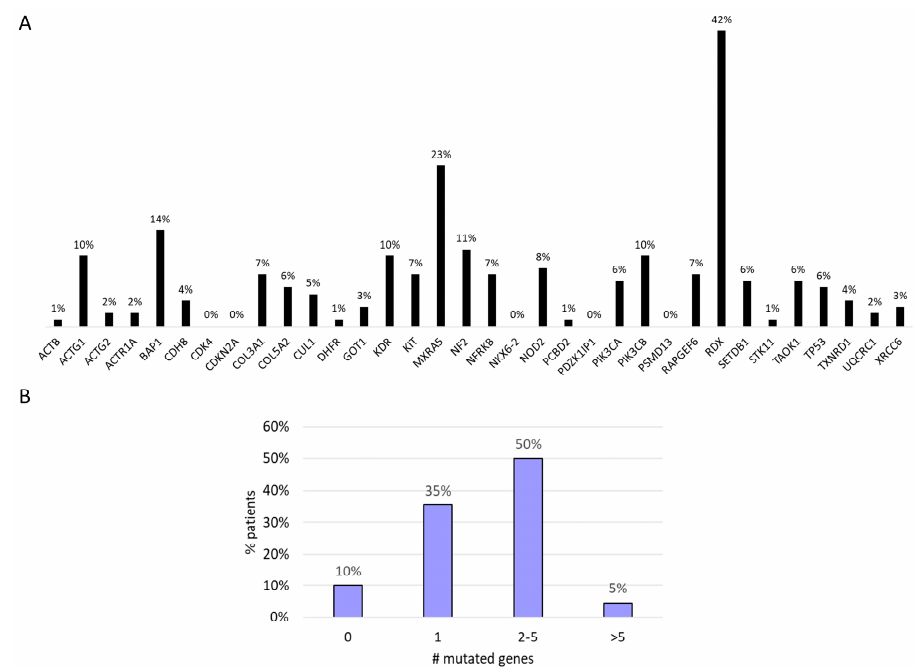
Figure 2. ( A ) Mutational profile. ( B ) Number of gene mutations per patients.